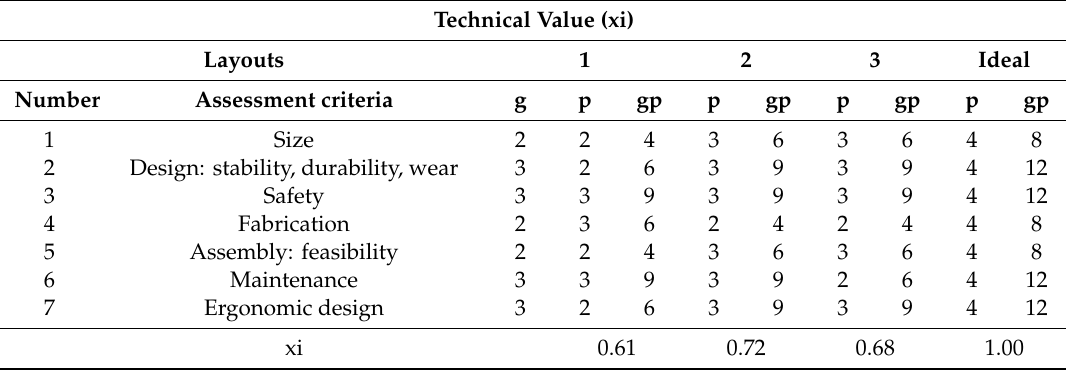
Table 2. Technical assessment of the preliminary layouts.